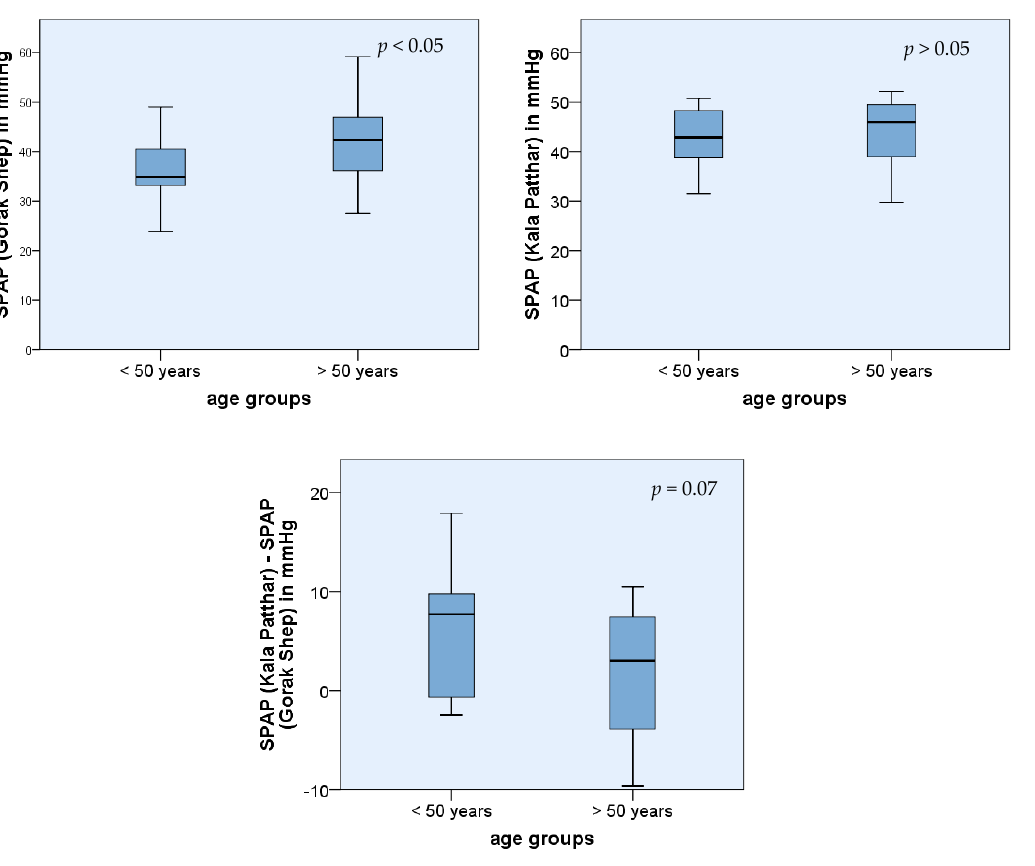
Figure 1. Pulmonary hypertension of participants at Gorak Shep ( a ) and at the summit of Kala Pat- thar ( b ) ( n = 27).